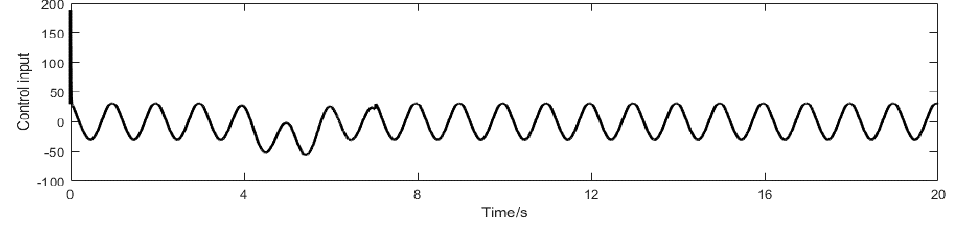
Figure 15. SMF controller output.